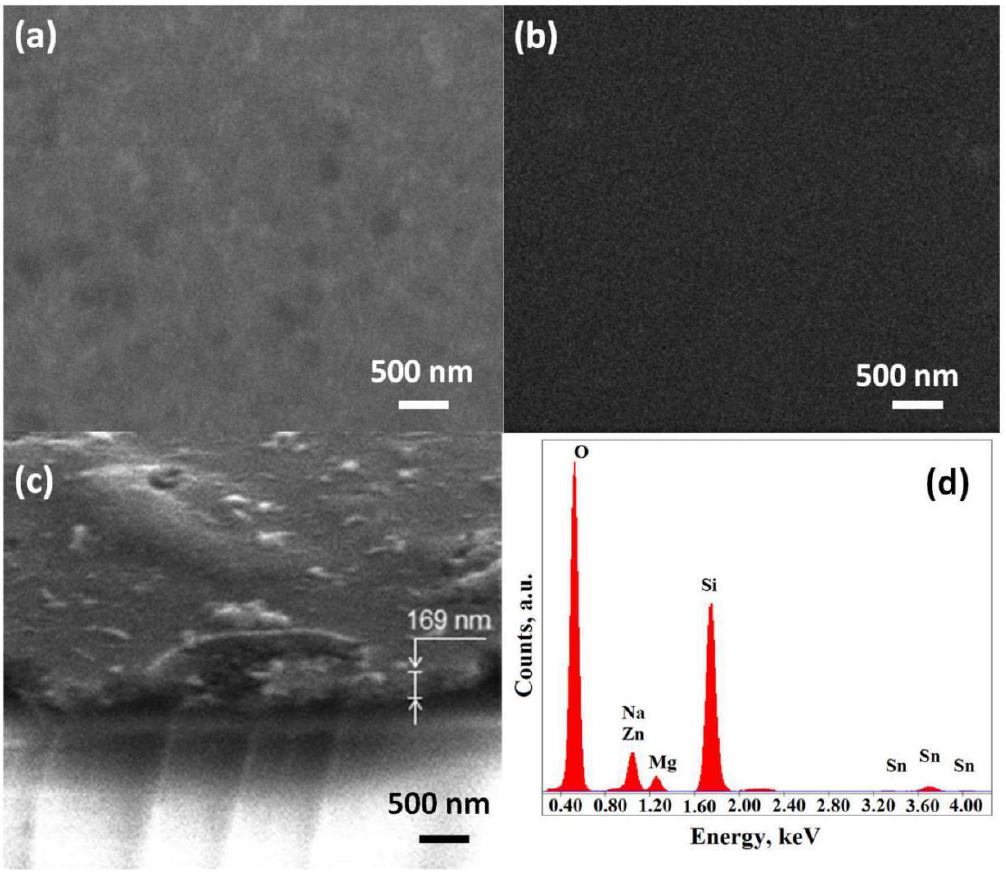
Figure 2. SEM images of materials 1 ( a ) and 2 ( b ) and surfaces and typical fragment ( c ), and EDX spectra ( d ) of material 1 film.